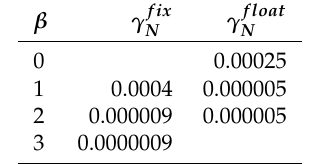
and γ float as a function of β . N N